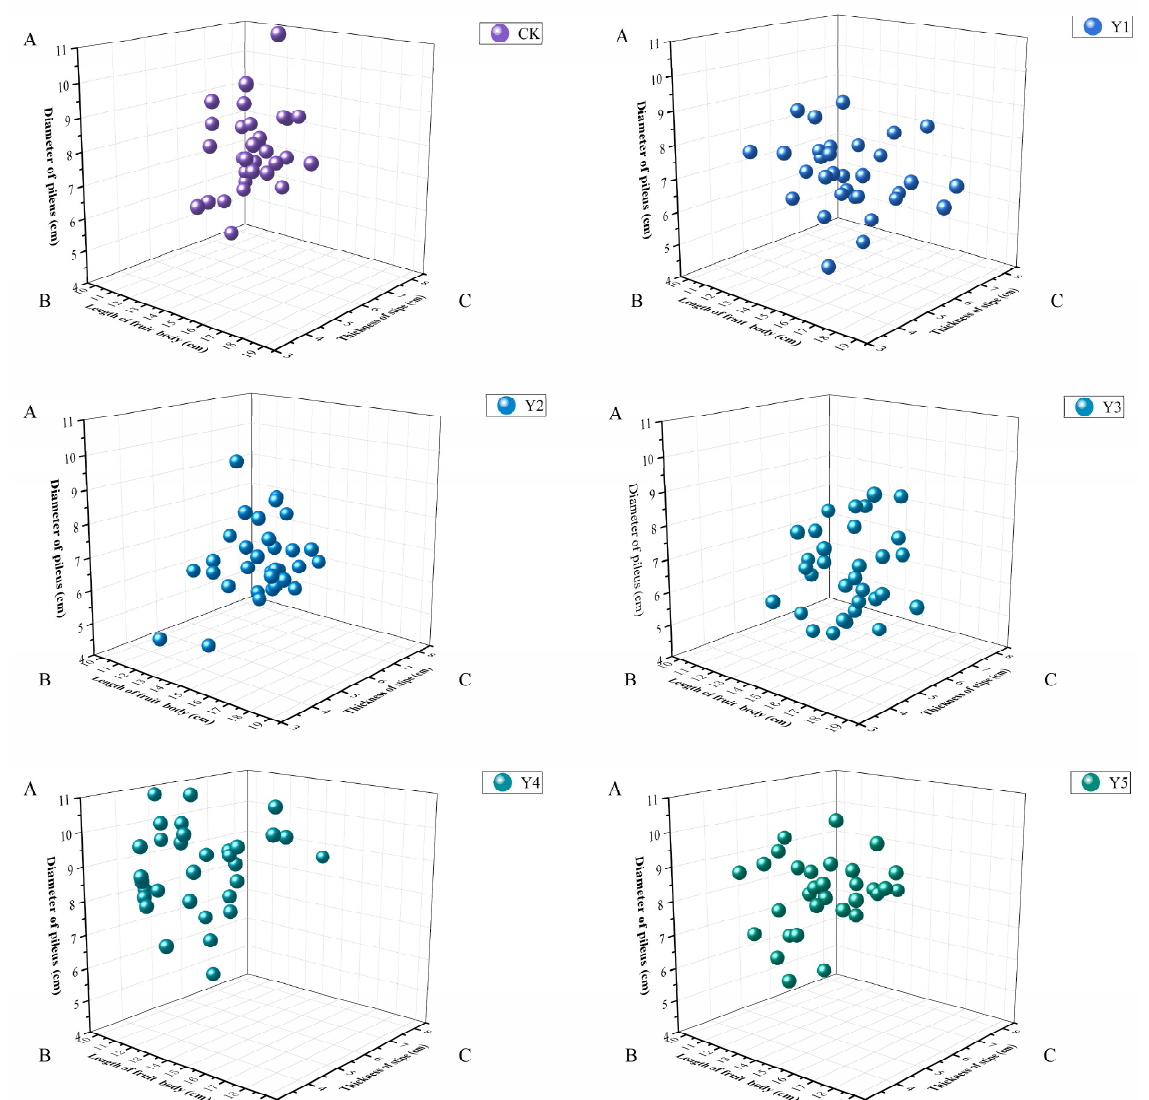
Figure 3. Scatter plot of the agronomic characteristics of fruiting bodies. A (cm): Diameter of the pileus, B (cm): Fruiting body length, C (cm): Stipe thickness.